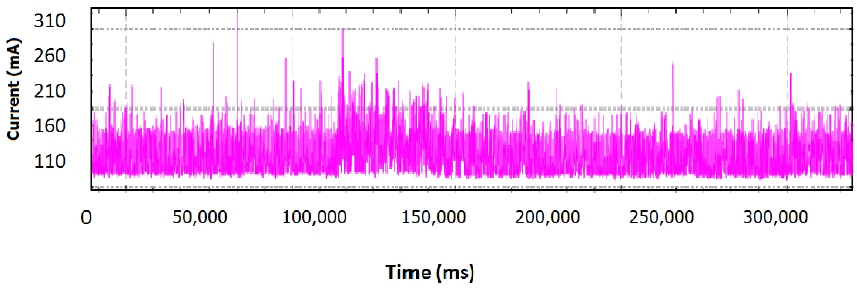
Figure 4. Smart Thermometer with damaged sensor.